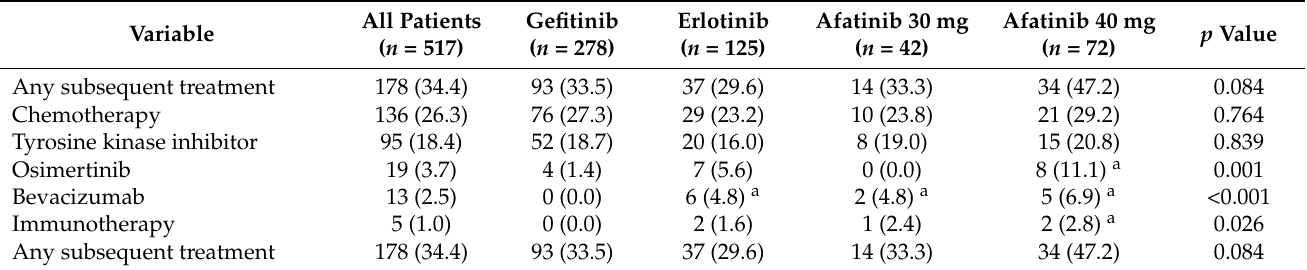
Table 4. Subsequent treatment.